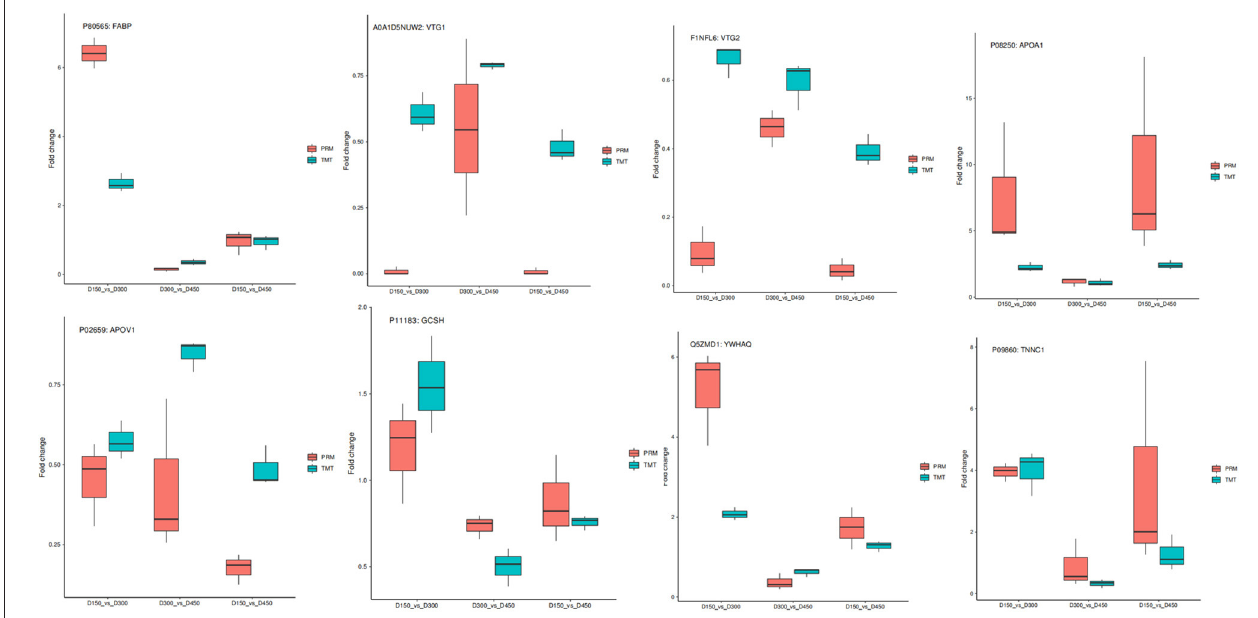
FIGURE 9 | Relative expression levels of selected proteins measured by PRM and TMT in the three comparison groups of D150 vs. D300, D300 vs. D450, and D150 vs.